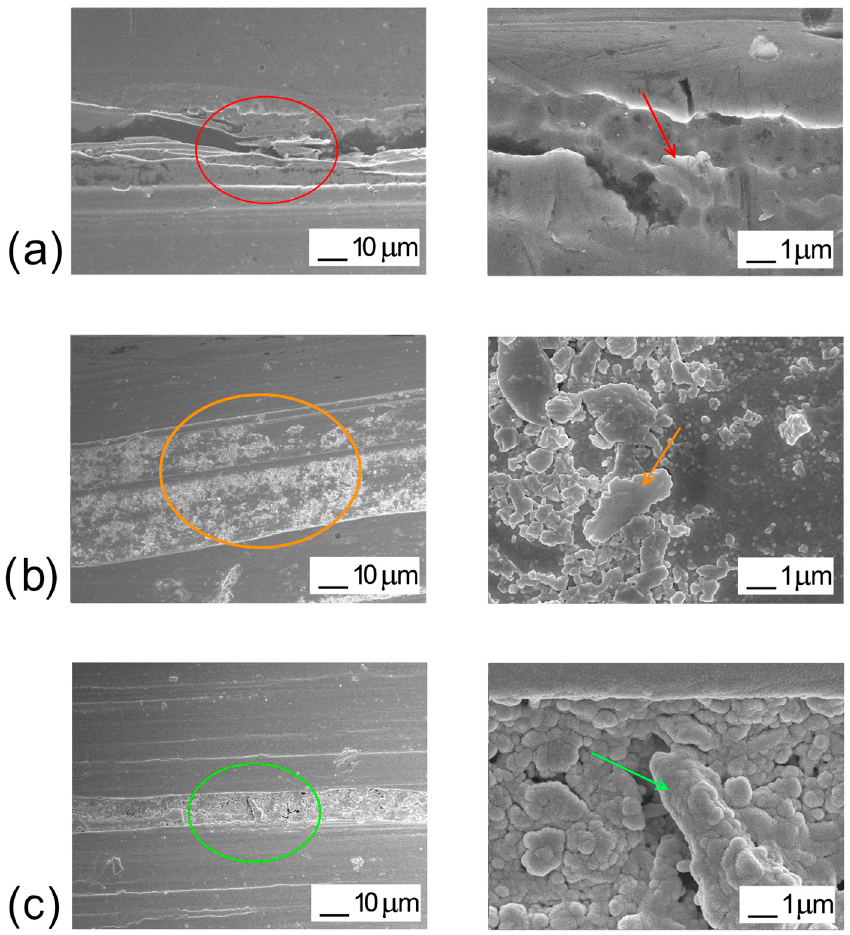
Figure 8. SEM micrographs of the large surface microdefects of TiNi substrates and the noble metal films formed on them: ( a ) bare TiNi; ( b ) Au/TiNi; and ( c ) Ir/Au/TiNi. Magnification 1000 times ( left ) and 10,000 times ( right , circle-marked areas). Circles mark areas captured at high magnification. The arrows indicate examples of secondary surface agglomerates ( b , c ) at the large surface microdefects of initial TiNi surface ( a ).